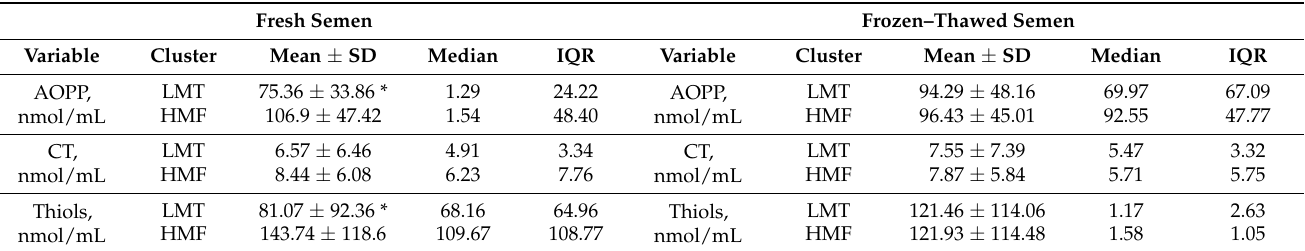
Table 2. Oxidative stress markers in seminal plasma of fresh and frozen–thawed semen in high- motility and low-motility clusters (respectively HMF and LMF for fresh semen and HMT and LMT for thawed